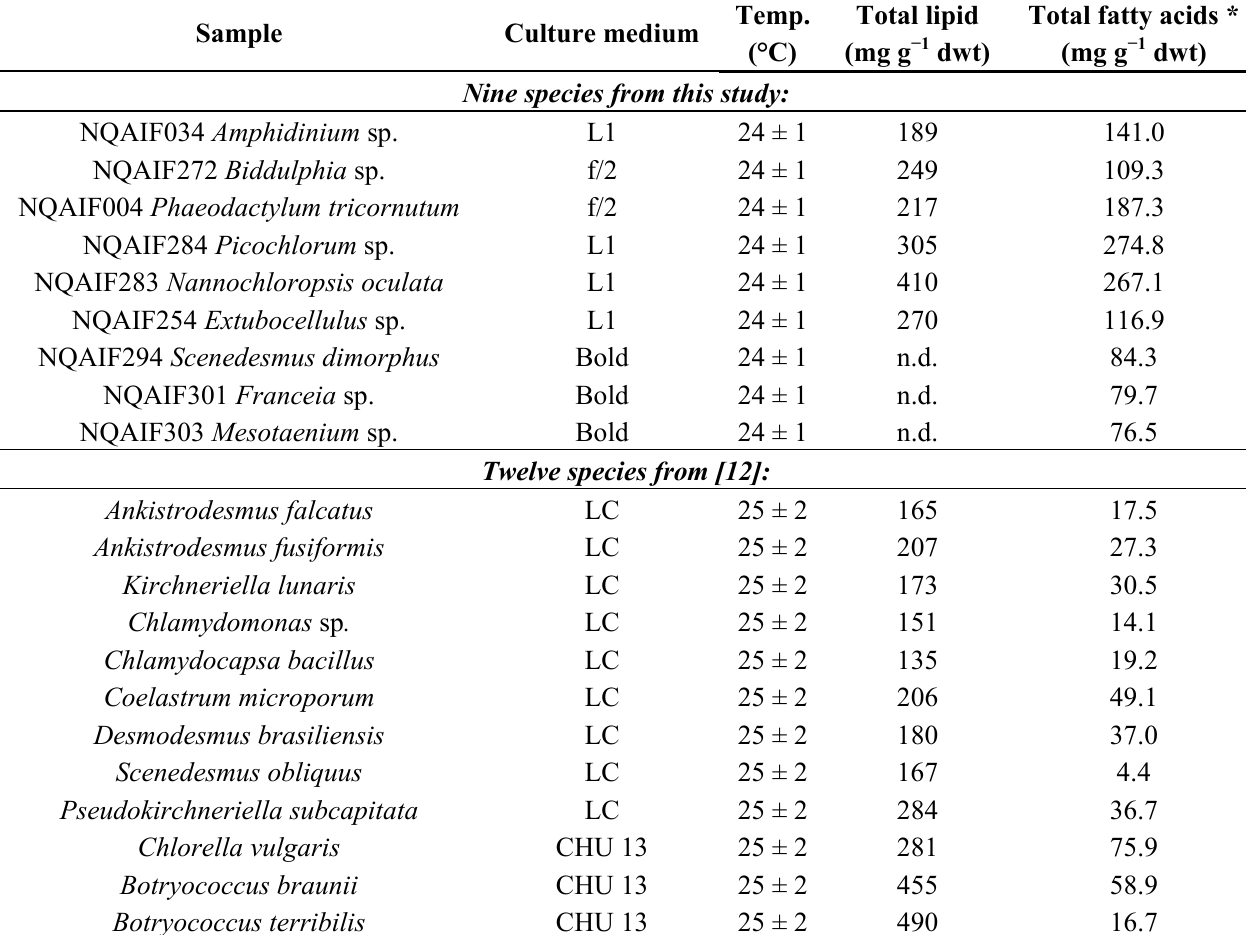
Table 1. Growth media, cultivation temperature, total lipid and total fatty acid content of nine microalgal species from this study and twelve green microalgal species from